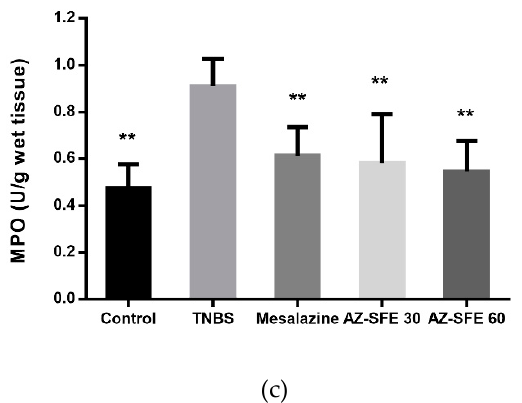
Figure 7. Effects of AZ-SFE (30 and 60 mg/kg) and mesalazine (400 mg/kg) on oxidative stress indicators in colons of TNBS-induced colitis in rats. ( a ) Superoxide dismutase (SOD). ( b ) Malonic dialdehyde (MDA). ( c ) Myeloperoxidase (MPO). Data are presented as mean ± SD of 6 rats per group. ** p < 0.01 versus TNBS group.